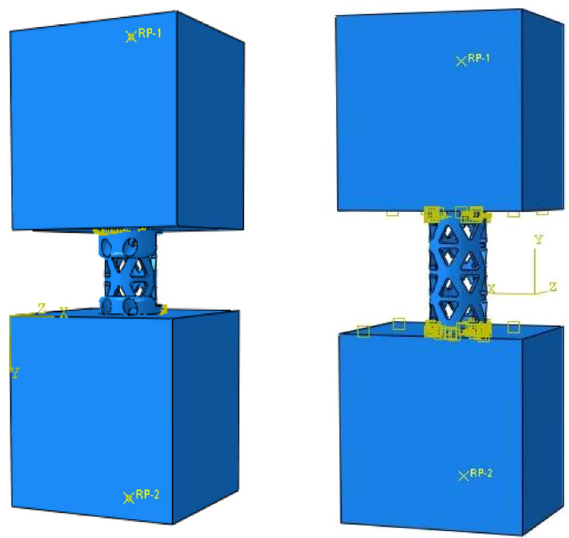
Figure 3. Schematic diagram of diagram of boundary conditions and load settings for the novel titanium mesh cage (NTMC) and traditional titanium mesh cage (TTMC) (Solidworks 2016, SOLIDWORKS Co,